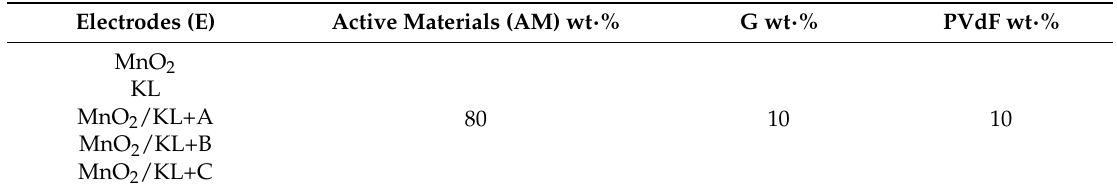
Table 8. Ratios of components used to prepare electrodes (wt ·